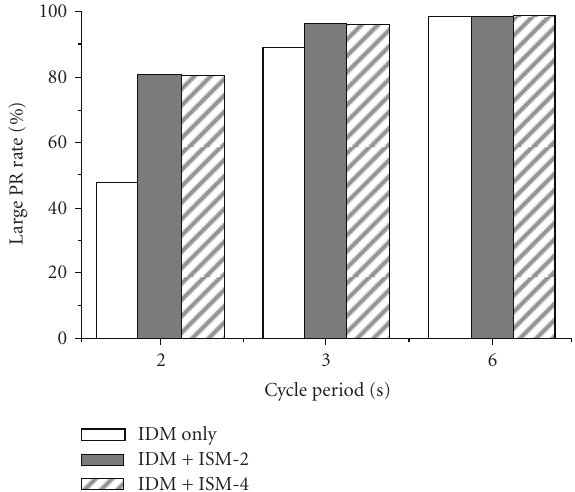
Figure 10: Large PR rate after IDM learning for each FEL-FES controller.